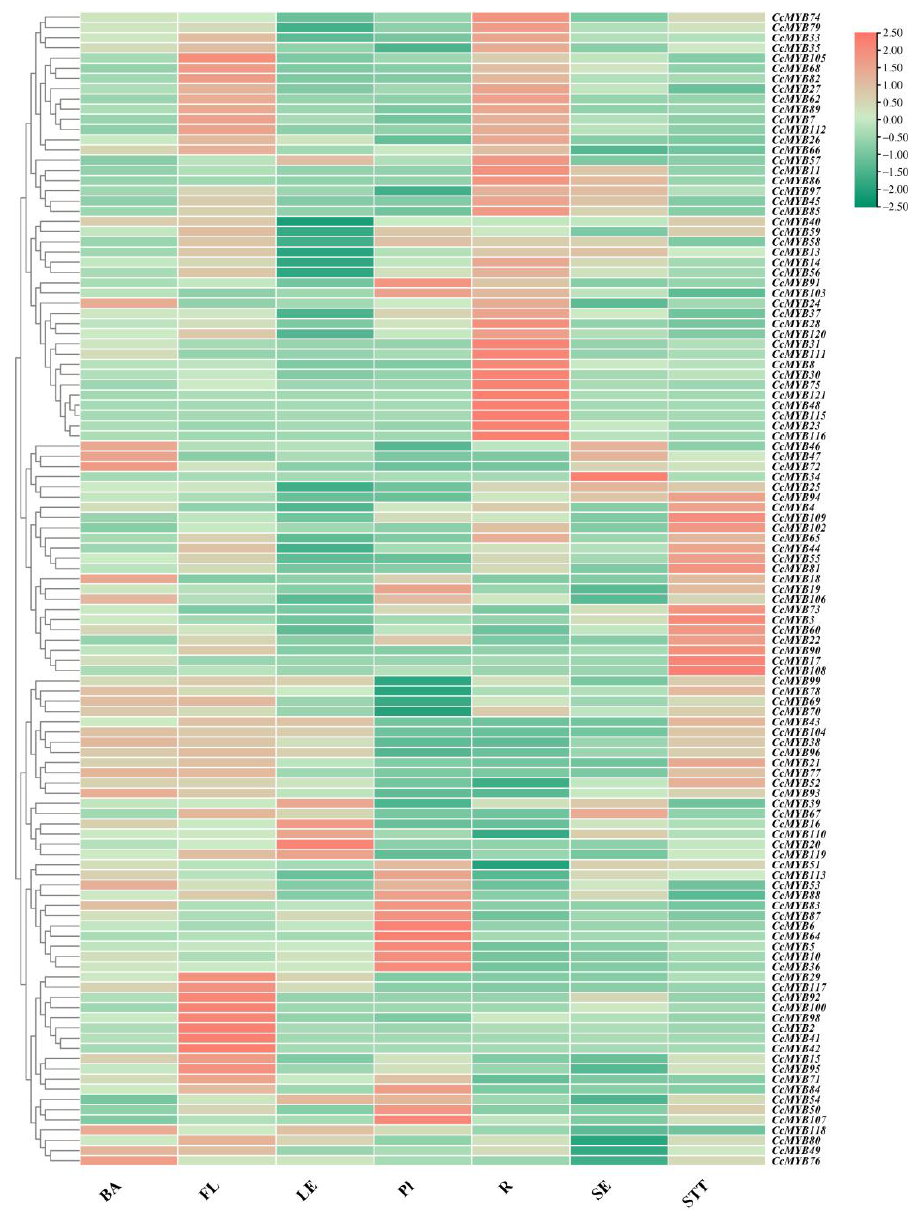
Figure 6. The expression of CcMYBs in different tissues by RNA-Seq. Expression of different CcMYBs in phloem (BA), flower (FL), leaf (LE), xylem (Pl), root (R), seed (SE), and stem (STT), with the vertical axis showing gene names and the horizontal axis showing different tissues. The different colors correspond to fold changes in log2, with green and red indicating downregulation and upregulation, respectively.